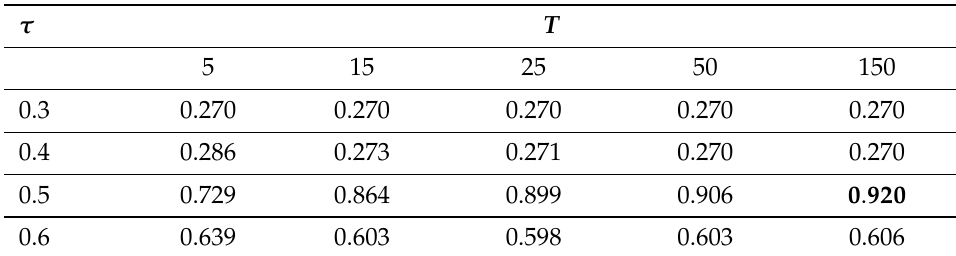
Table 3. F1-scores of the original iForest as a function of the number of trees T and the hyperparameter τ for the Circle